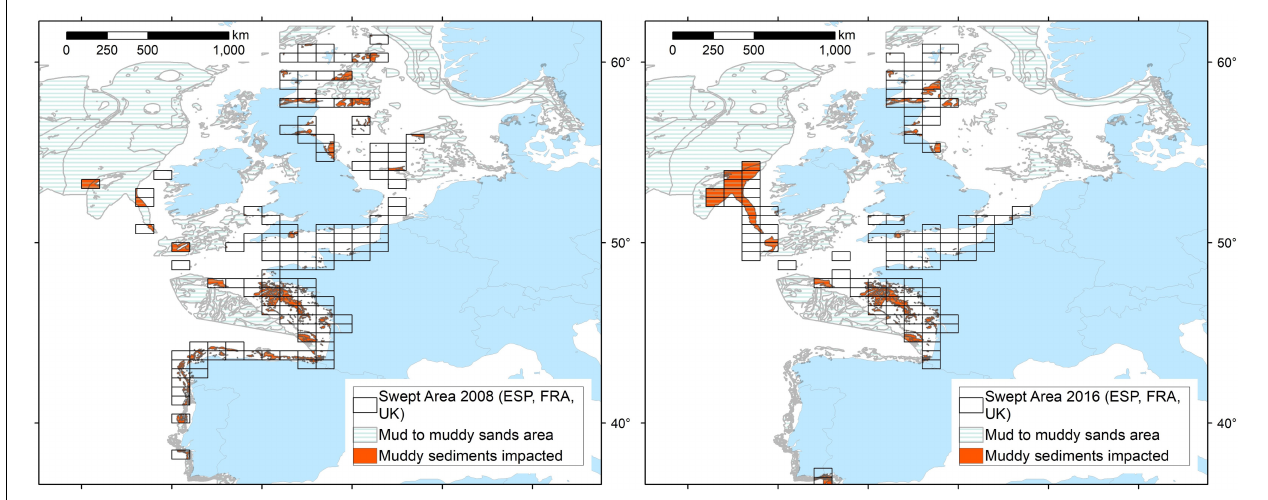
FIGURE 4 | Swept area by otter trawlers that landed hake for Spain, France, and the United Kingdom in 2008 and 2016 overlaid with muddy sediment types, with impacted muddy sediments highlighted (EMODnet Geology, 2016).